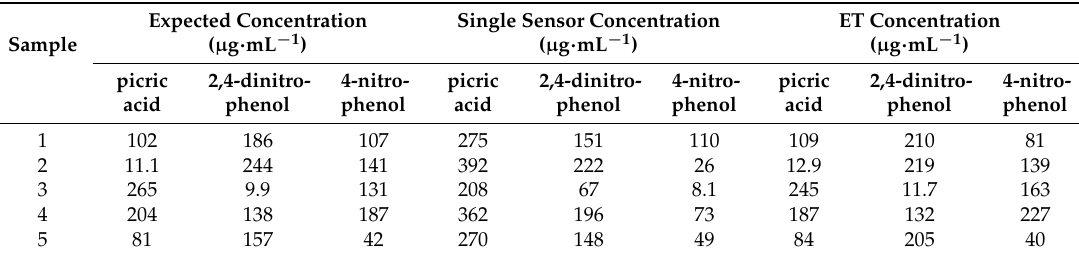
Table 2. Compound concentrations found using the graphite epoxy composite electrode (single sensor approach) and the ET model for 5 water